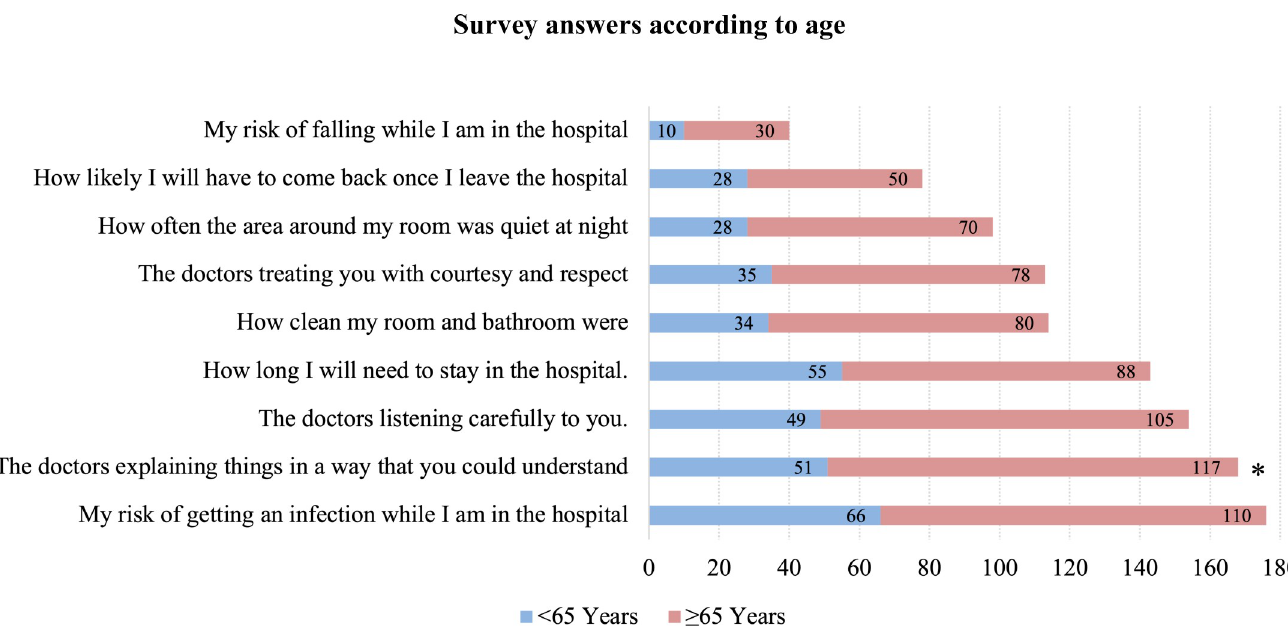
Fig 3. Survey answers according to age. Frequency of participants that answered each question as “Very Important” in the hospital care, according to age. � Statistically significant.